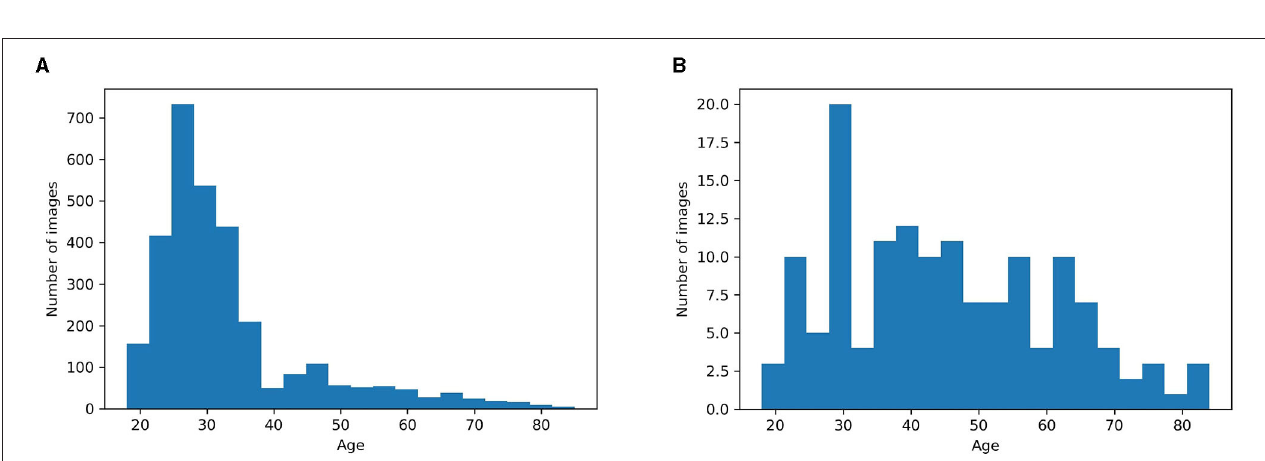
FIGURE 3 | (A) Age distribution of subjects in the training set. (B) Age distribution of subjects in our testing set. We randomly selected 10 images every 5 years to obtain a uniform distribution of images throughout the age.